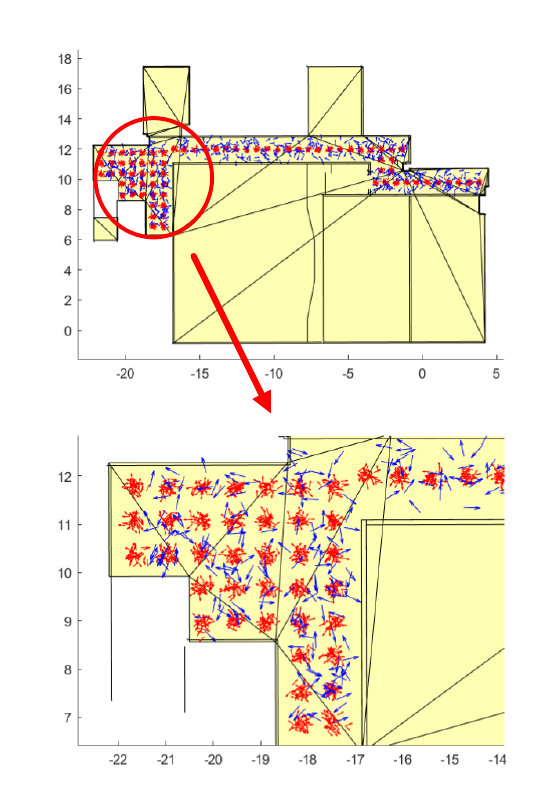
Figure 5. The generated training and test synthetic lidar